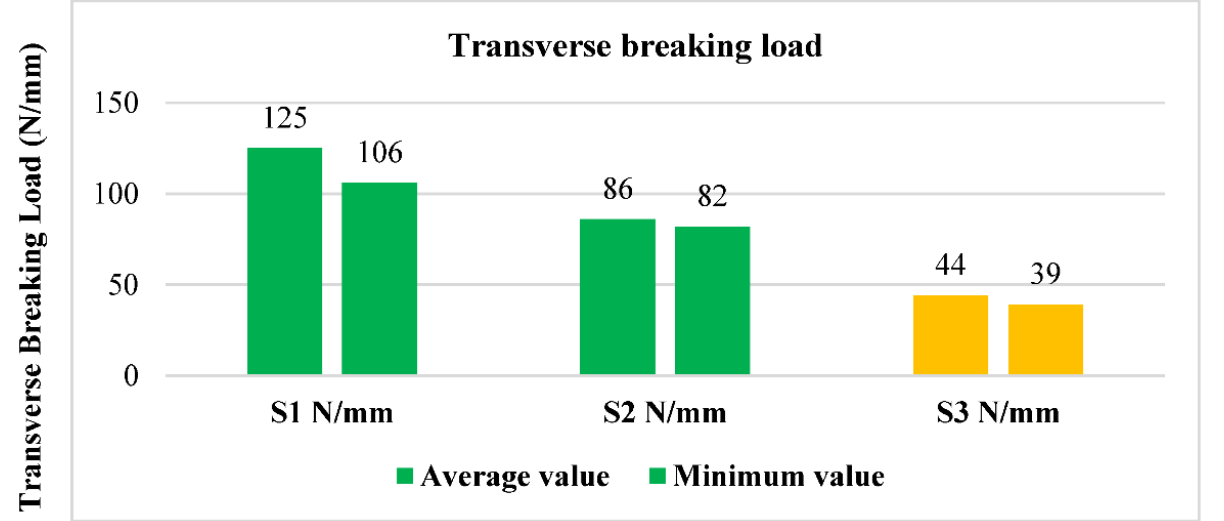
Figure 10. Results of transverse braking load.